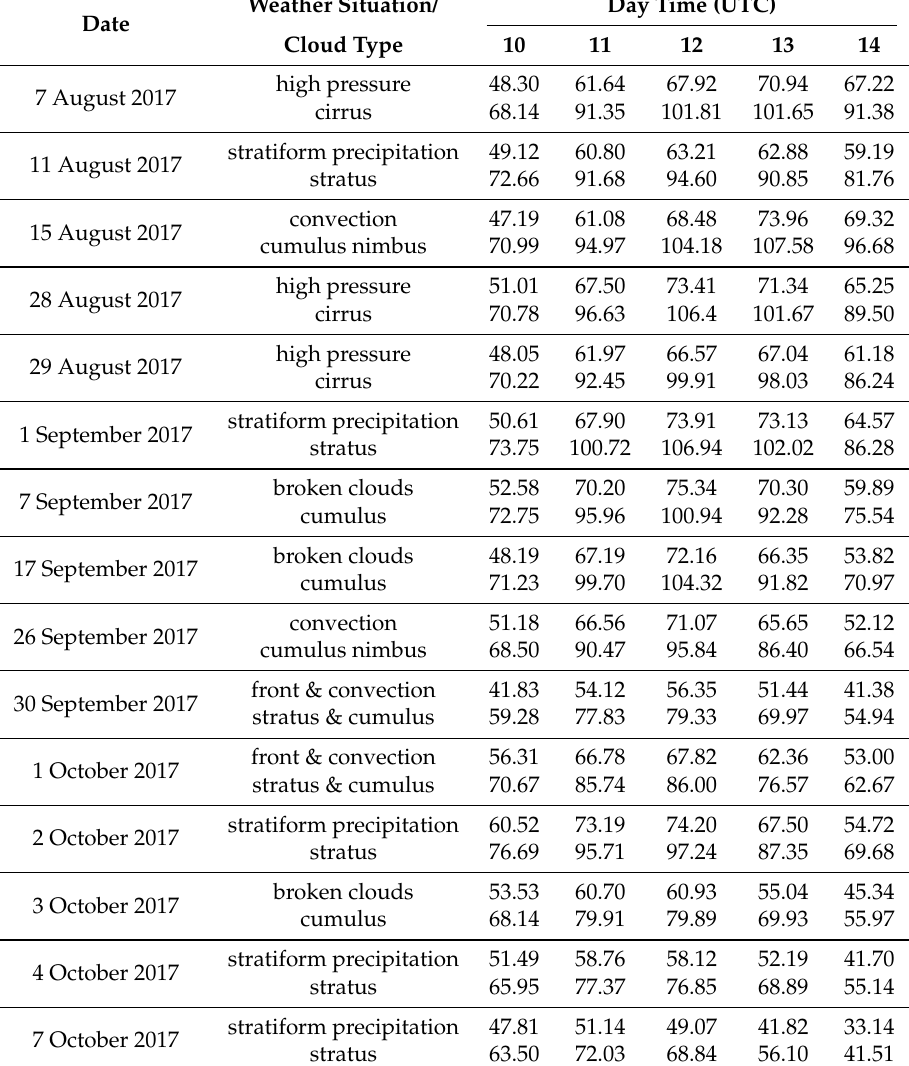
Table A1. List of investigated cases with corresponding main weather situation and cloud type over Germany. The upper row shows the MAE and the lower row shows the RMSE, respectively. The unit for the error measures is W/m 2